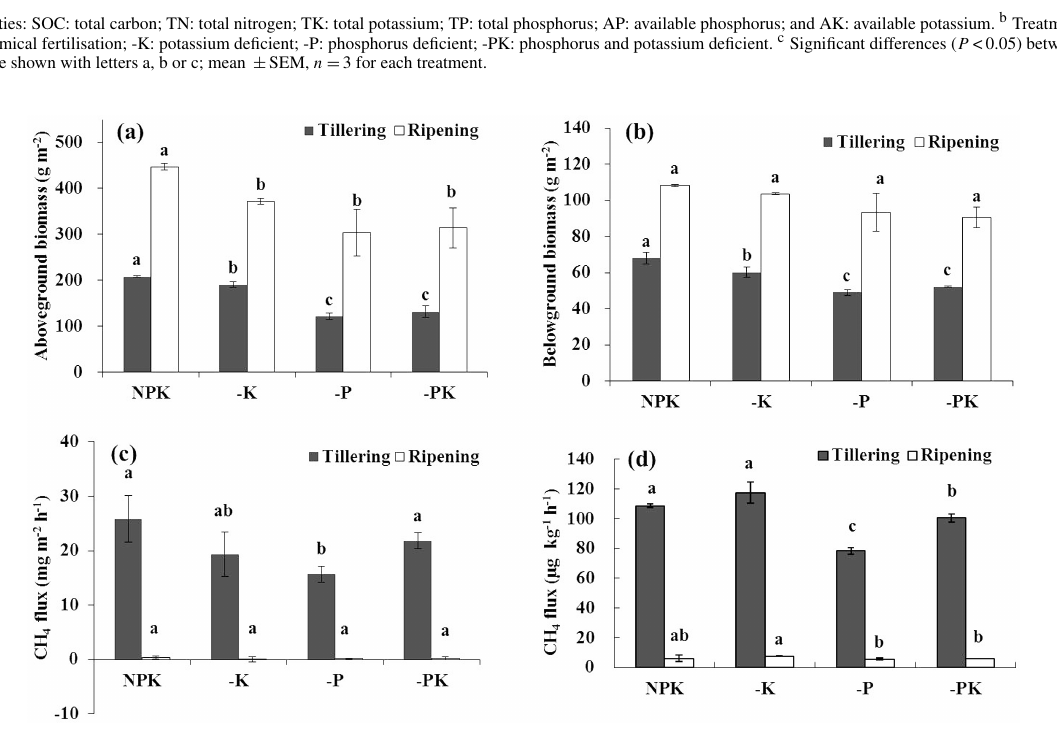
Figure 1. Aboveground (a) and belowground (b) plant biomass and methane flux from field plots (c) and soil incubation (d) at rice tillering stage and rice ripening stage. NPK: balanced chemical fertilisation; − K: potassium deficient; − P: phosphorus deficient; − PK: phosphorus and potassium deficient. Significant differences ( P <0.05) between the treatments are shown with letters a, b or c; mean ± SEM, n = 3 for each treatment. Statistical analysis for soils from tillering stage and ripening stage were conducted